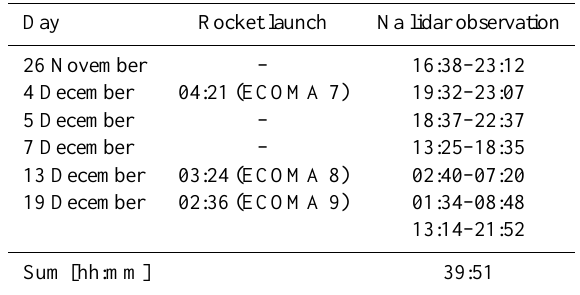
Table 2. Rocket launches and lidar observations during the ECOMA campaign 2010. Only days with more than three hours of data are listed. Times are given in [hh:mm] format in UT. Local time is UT plus one